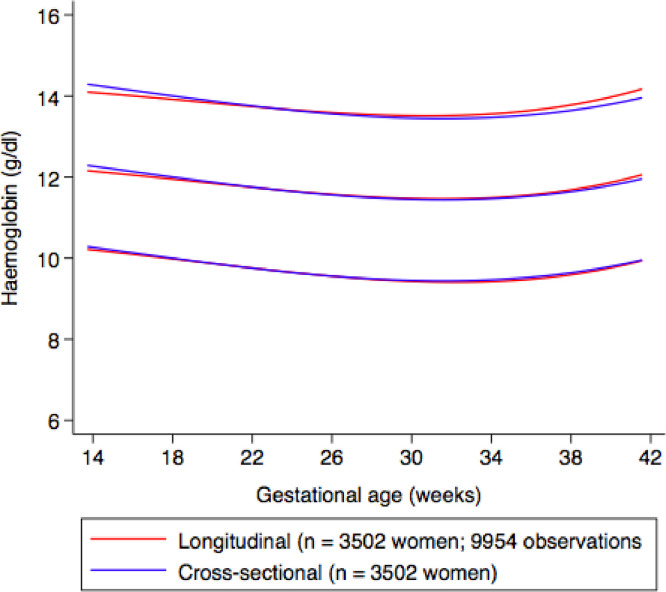
represents sensitivity analyses showing the smoothed, gestational age-specific, 3rd, 50th and 97th centiles for maternal haemoglobin from the total Fetal Growth Longitudinal Study using longitudinal data (n = 3502 women, 9954 observations) (red) compared to a cross-sectional random sample of haemoglobin data between 14+0 and 40+0 weeks’ gestation for each woman included in the study (n = 3502 observations) (blue). (For interpretation of the references to color in this figure legend, the reader is referred to the web version of this article.)